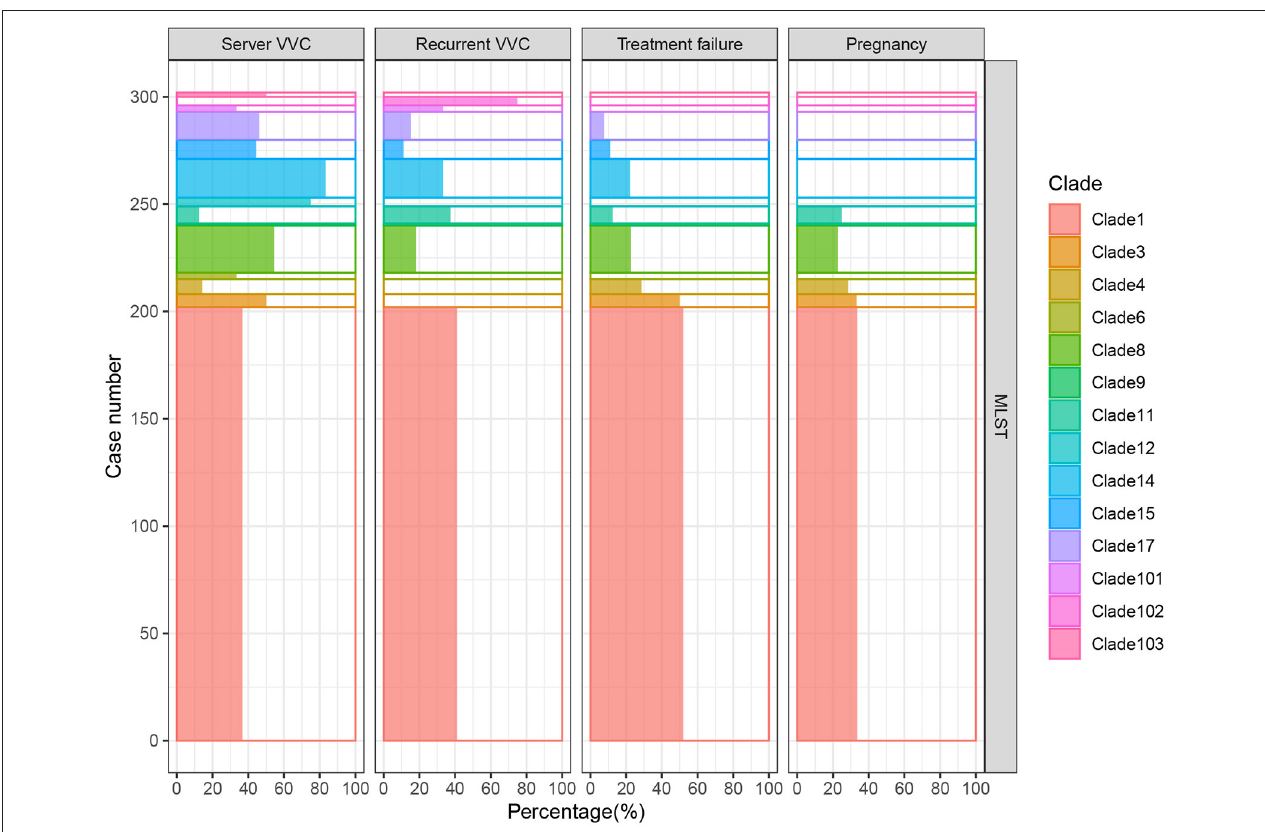
FIGURE 2 | RVVC cases and VVC cases with treatment failure were mainly caused by C. albicans in MLST clade 1. In total, 306 samples were analyzed, and the 14 detected clades are presented in different colors. The percentage of clinical characteristics, including severe VVC, RVVC, treatment failure, and pregnancy cases, in each group is shown on the X axis. Clade 1 was dominant in RVVC and treatment failure cases, which demonstrated that VVC caused by invasive clade 1 C. albicans was more difficult to cure and relapsed more easily. Although isolates of clade 14 accounted for the highest proportion of severe VVC cases, the cure rate reached 77.8% (14/18). This result revealed that the strains in clade 14 had higher virulence but lower drug